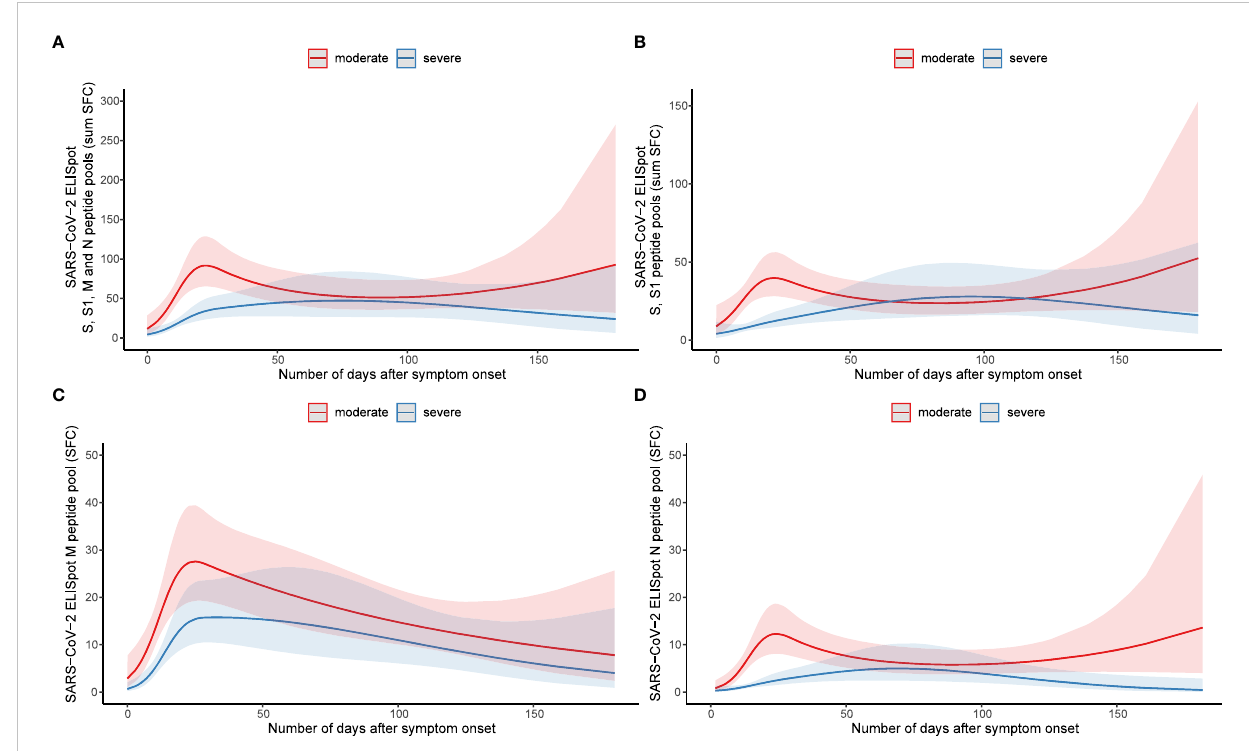
FIGURE 1 Longitudinal analysis of SARS-CoV-2 speci fi c T-cell responses measured by ELISpot with spike, membrane and nucleocapsid peptide pools in hospitalized patients with moderate and severe COVID-19. (A) Number of days after symptom onset in relation to T-cell reactivity with the sum of the total number of spot forming cells (SFC) measured by ELISpot with spike (S and S1), membrane (M), and nucleocapsid (N) peptide pools in moderate (n=90; red line) and severe COVID-19 (n=100; blue line) patients, using a binominal mixed model with the representation of the con fi dence limits by the shaded areas. (B) As (A) with the number of SFC measured with the S and S1 peptide pools. (C) As (A) with the number of SFC measured with the M peptide pool. (D) As (A) with the number of SFC measured with the N peptide